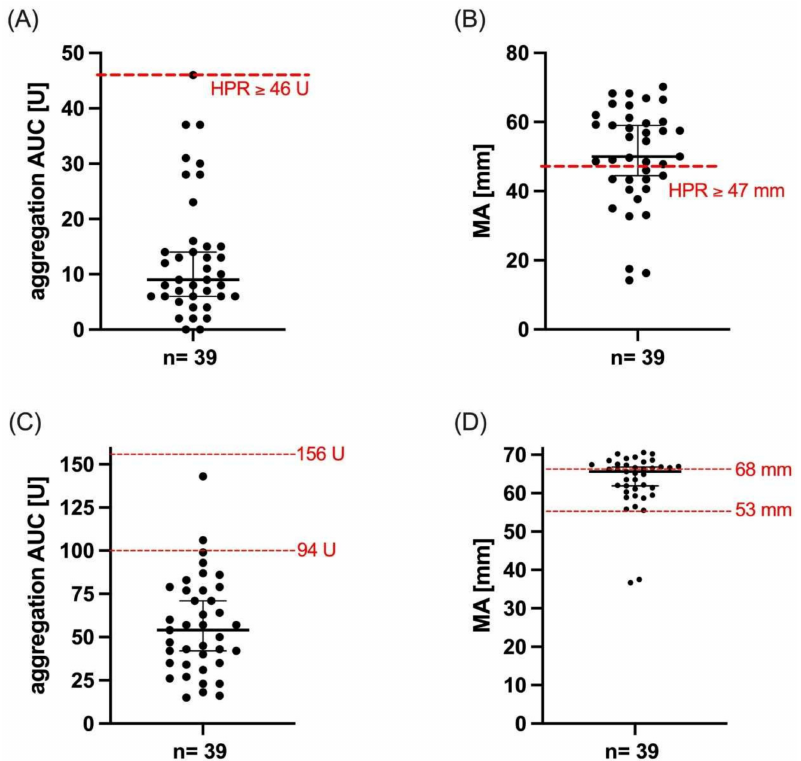
Figure 1. Platelet reactivity of patients with atrial fibrillation undergoing percutaneous inter- vention. ( A ) ADP- and ( C ) TRAP-induced aggregation as assessed by MEA and MA ADP ( B ) and MA Thrombin ( D ) as assessed by TEG. Median and interquartile range are represented by black lines. Red lines indicate conventional cut-off values (ADP AUC ≥ 46 U and MA ADP ≥ 47 mm) or reference values suggested by the manufacturer (TRAP AUC 94-156 U, MA Thrombin 53–68 mm), respectively. The rate of HPR was significantly higher if assessed by TEG compared with MEA 25 (64%) vs. 1 (3%); p < 0.001. Thirty-two (82%) patients received OAC on the day of platelet functioning measurement. No significant difference in ADP-induced aggregation (9 U vs. 11 U; p = 0.09) and MA ADP values (59.6 mm vs. 48.5 mm, p = 0.06) were shown when OAC